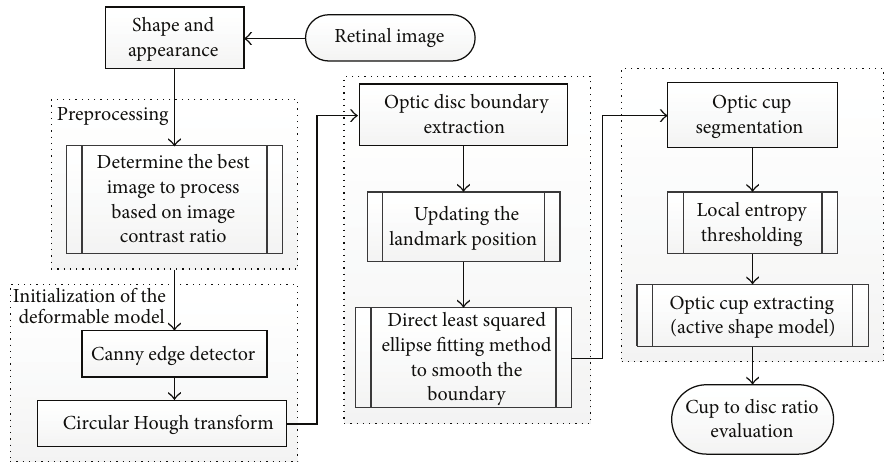
Figure 27: Flowchart for algorithm proposed in